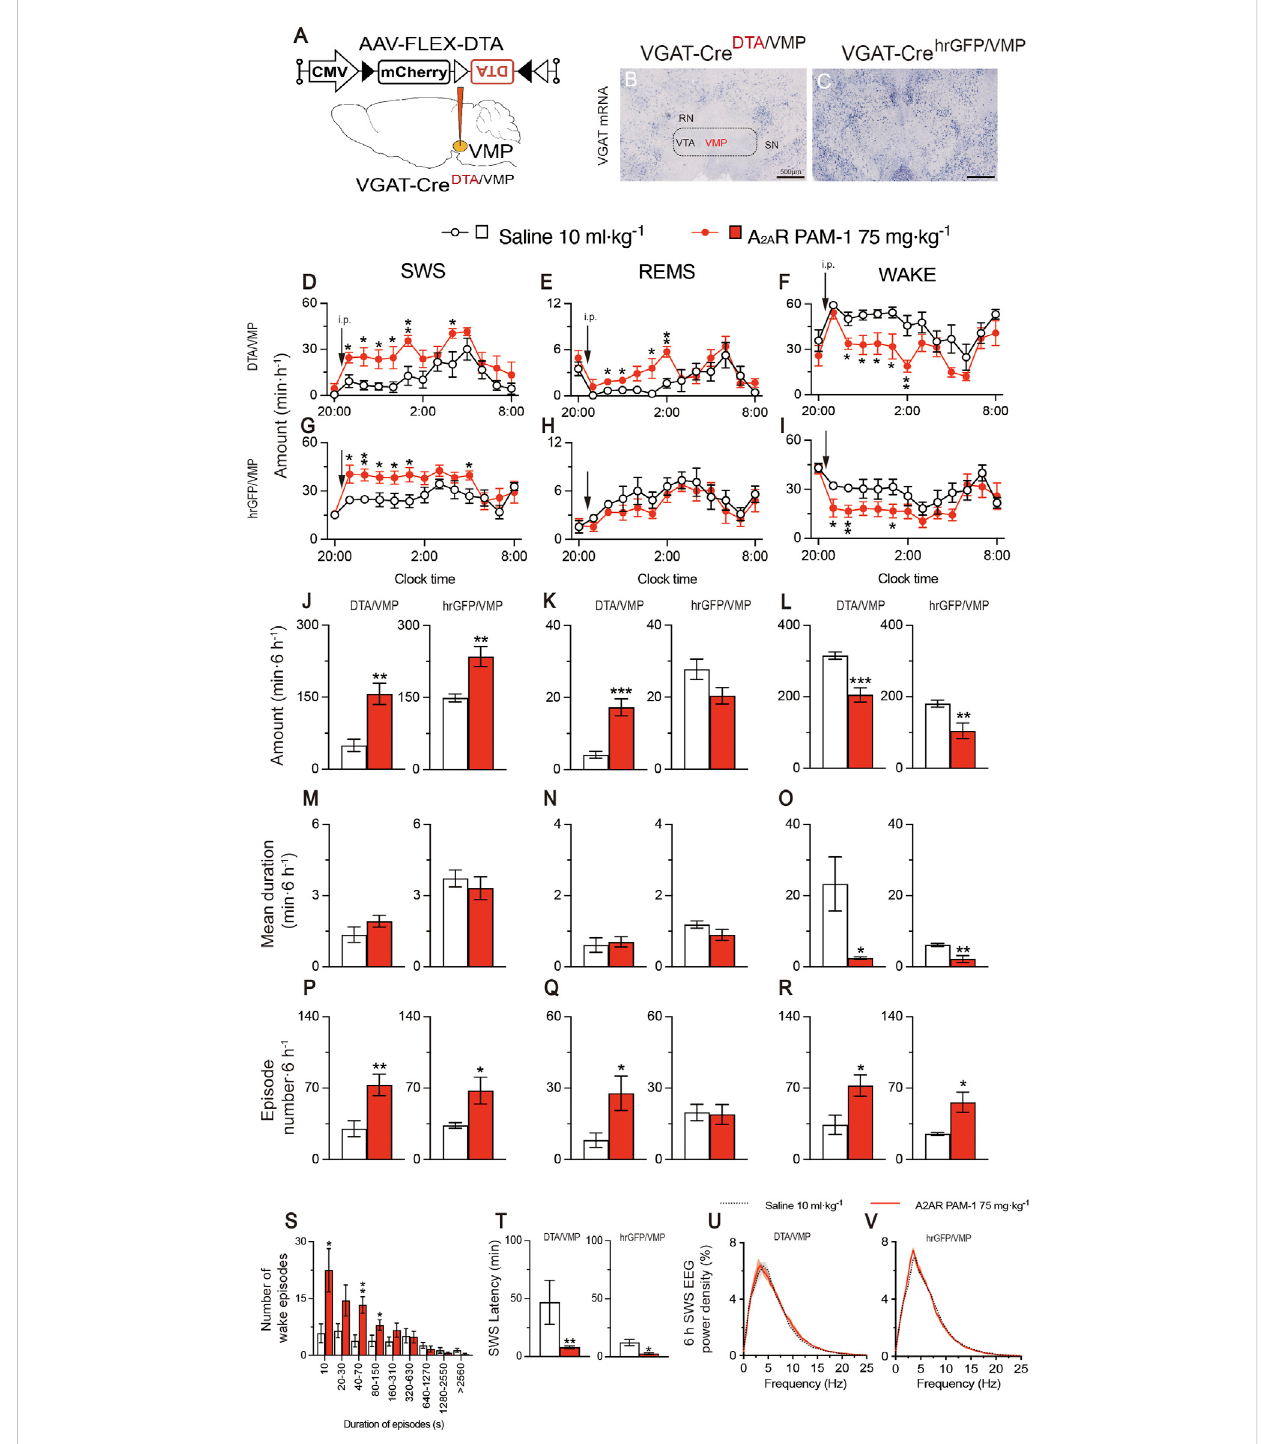
FIGURE 2 IntraperitonealadministrationofA 2A RPAM-1inducessleepinmicewithmania-likebehavior. (A) VGAT-CremicewereinjectedwithAAV-FLEX-DTA (VGAT-Cre DTA/VMP mice) or AAV-FLEX-hrGFP (VGAT-Cre hrGFP/VMP mice, control) into the VMP region. (B,C) Brain sections stained against VGAT mRNA in VGAT-Cre DTA/VMP (B) and VGAT-Cre hrGFP/VMP (C) mice con fi rm that the VMP GABAergic neurons were ablated in VGAT-Cre mice. RN, red nucleus; SN, substantia nigra; VTA, ventral tegmental area. Scale bar, 500 μ m. (D – R) Time course (D – I) , total amount (J – L) , mean duration (M – O) , and episode number (P – R) of SWS, REMS, and wakefulness in VGAT-Cre DTA/VMP and VGAT-Cre hrGFP/VMP mice after administration of saline or A 2A RPAM-1. (S) Wake episode spectrum in VGAT-Cre DTA/VMP mice. (T) Latency to sleep onset in VGAT-Cre DTA/VMP and VGAT-Cre hrGFP/VMP mice after administering saline or